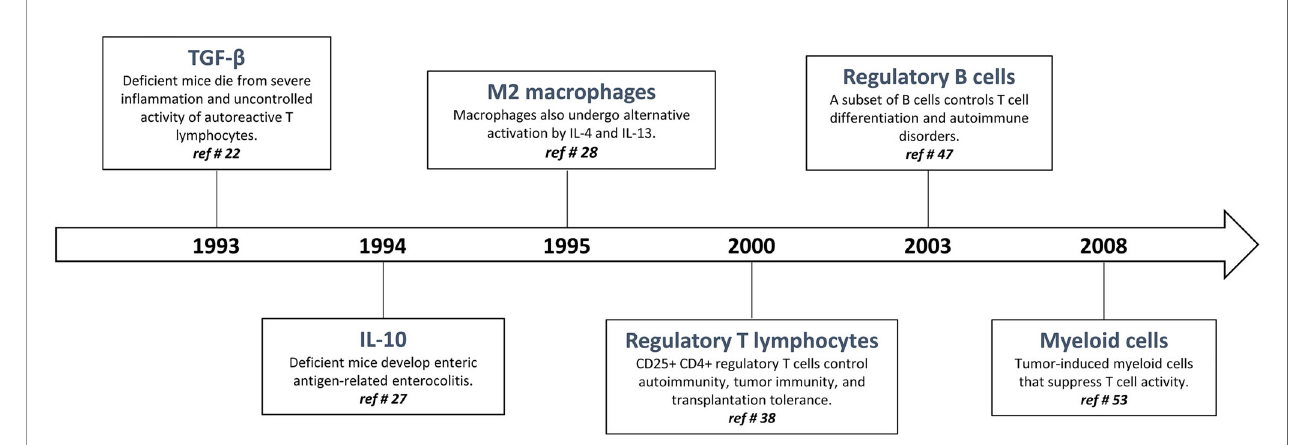
FIGURE 1 | Timeline: historical progression of immunoregulation in